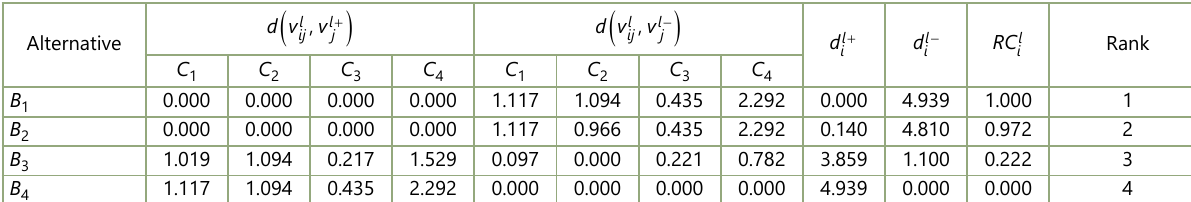
Table 19. The distances from the ideal and anti-ideal solutions with calculated rank indicator for sensitive products ( l = 2) (source: own